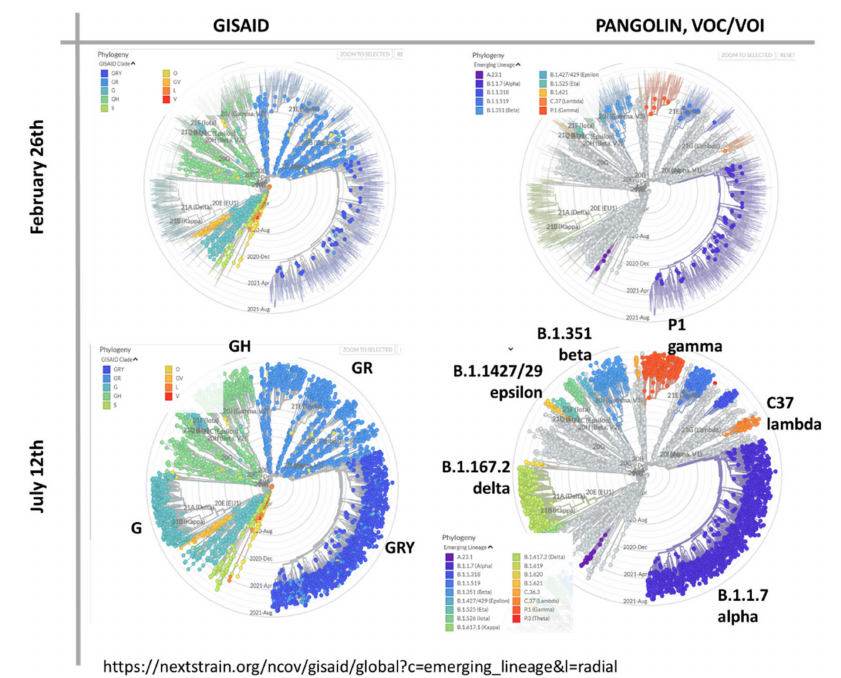
Figure A10. Radially displayed phylogenetic tree of of SARS-CoV-2 available in February ( above ) and July 2021 ( below ). The various types are color coded (using GISAID (left part) and PANGOLIN (right part) nomenclatures (Source: https://nextstrain.org; 27 July 2021). Only GSAID lineage GRY virtually one-to-one matches with VOC alpha. The others VOCs/VOIs distribute over different GISAID lineages. Our SNV-spot profiles (Figure A6) reflect these